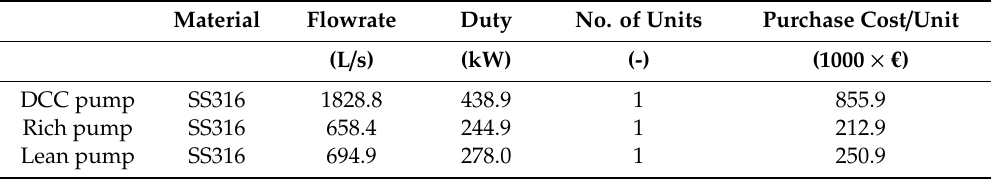
Table A3. Pumps dimensions and purchase costs from Aspen In-Plant Cost Estimator V11 (purchased cost year: 2018).